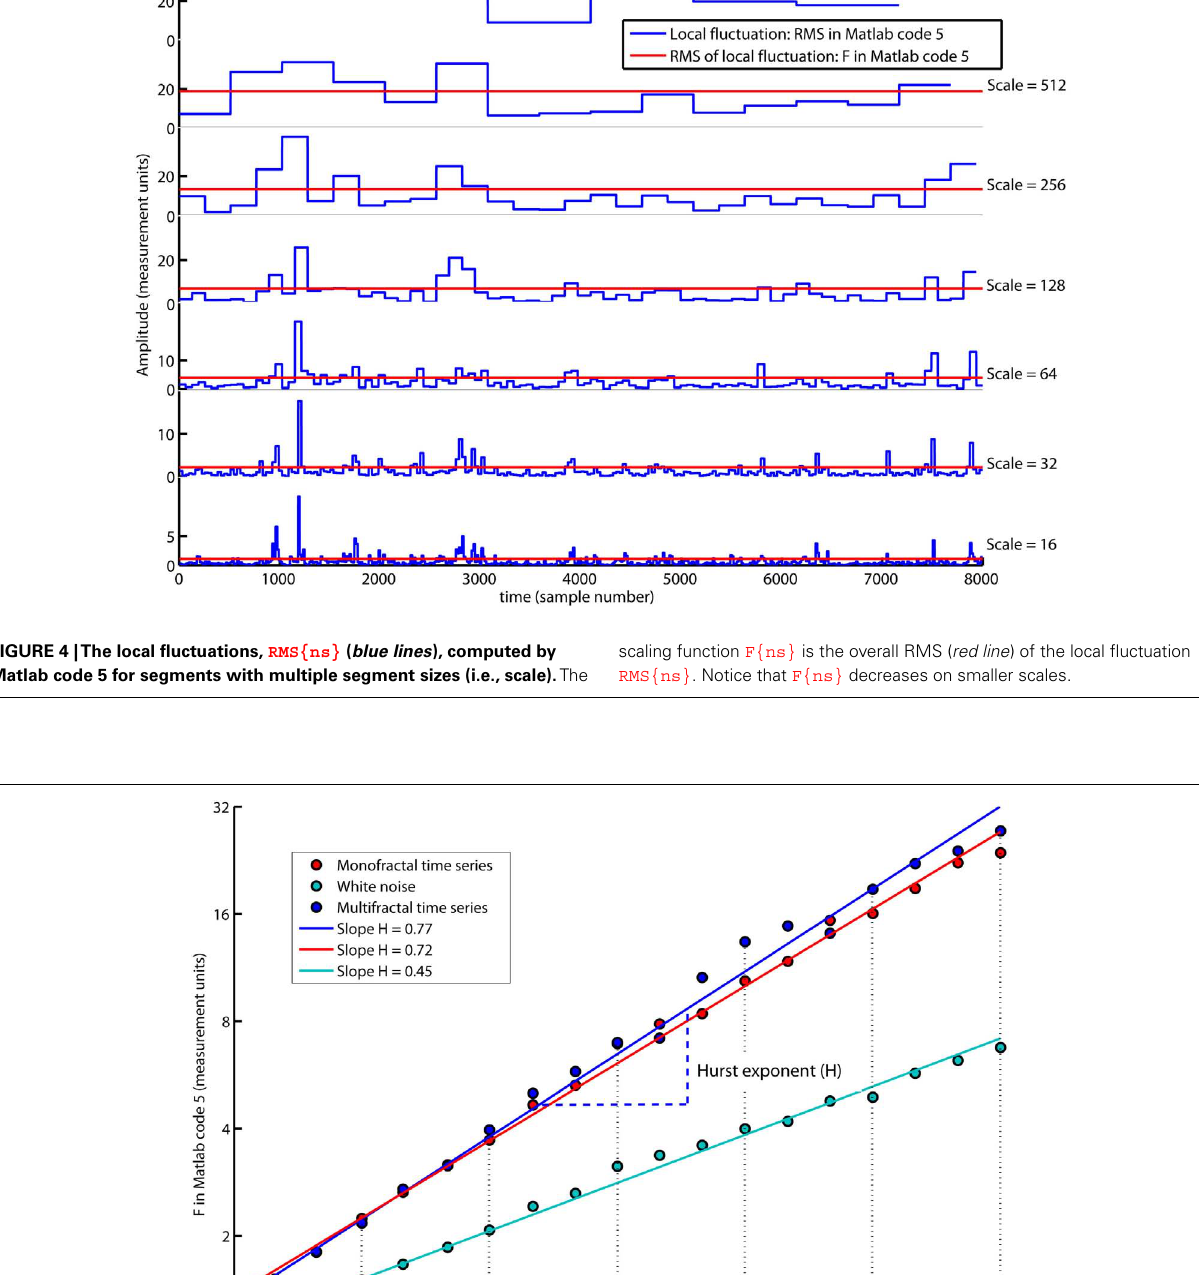
called the Hurst exponent because F and scale are represented in log-coordinates. Notice that both the monofractal and multifractal time series have more apparent slow fluctuations compared to whitenoise indicated by larger amplitudes of the overall RMS on the larger